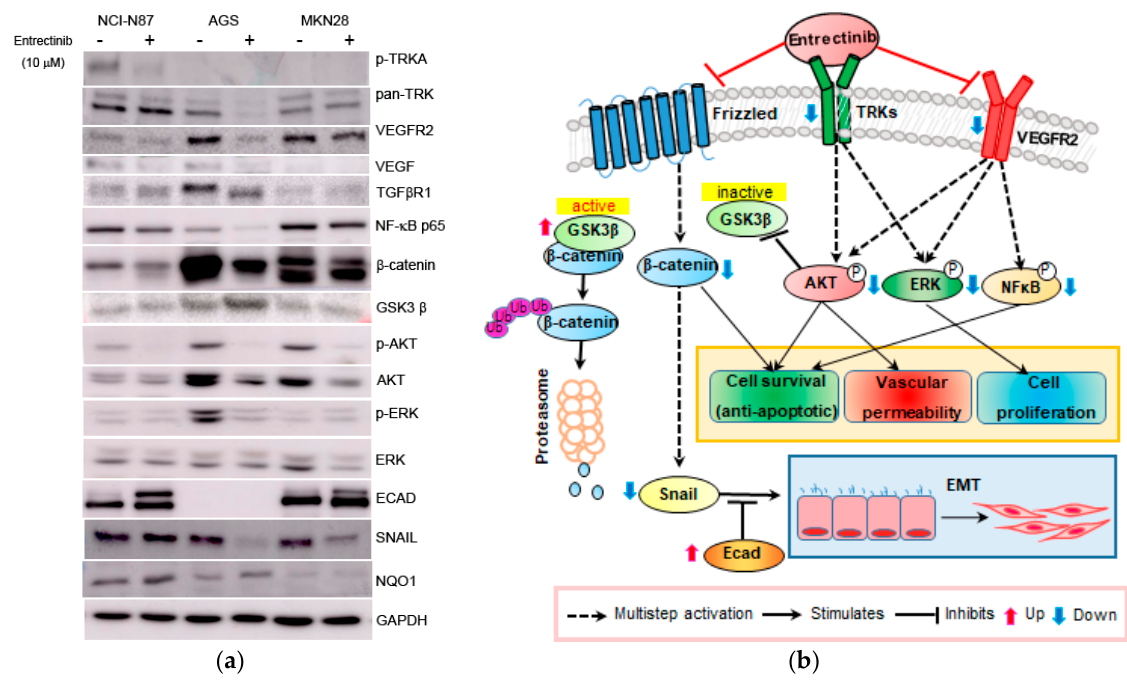
Figure 6. Effects of entrectinib on protein expression in gastric cancer cell lines. ( a ) Protein expression of NCI-N87 (high expression of NTRK1-3 but mutation of NTRK3), AGS (middle expression of NTRK1-3), and MKN28 (low expression of NTRK1-3) gastric cancer cell lines. ( b ) Graphic overview of entrectinib-targeted interventions in GC cancer cells. Protein expression levels of TRK, p-NFkB p65, ECAD, β -catenin, p-AKT, AKT, p-ERK, ERK, and NQO1 were determined using immunoblot